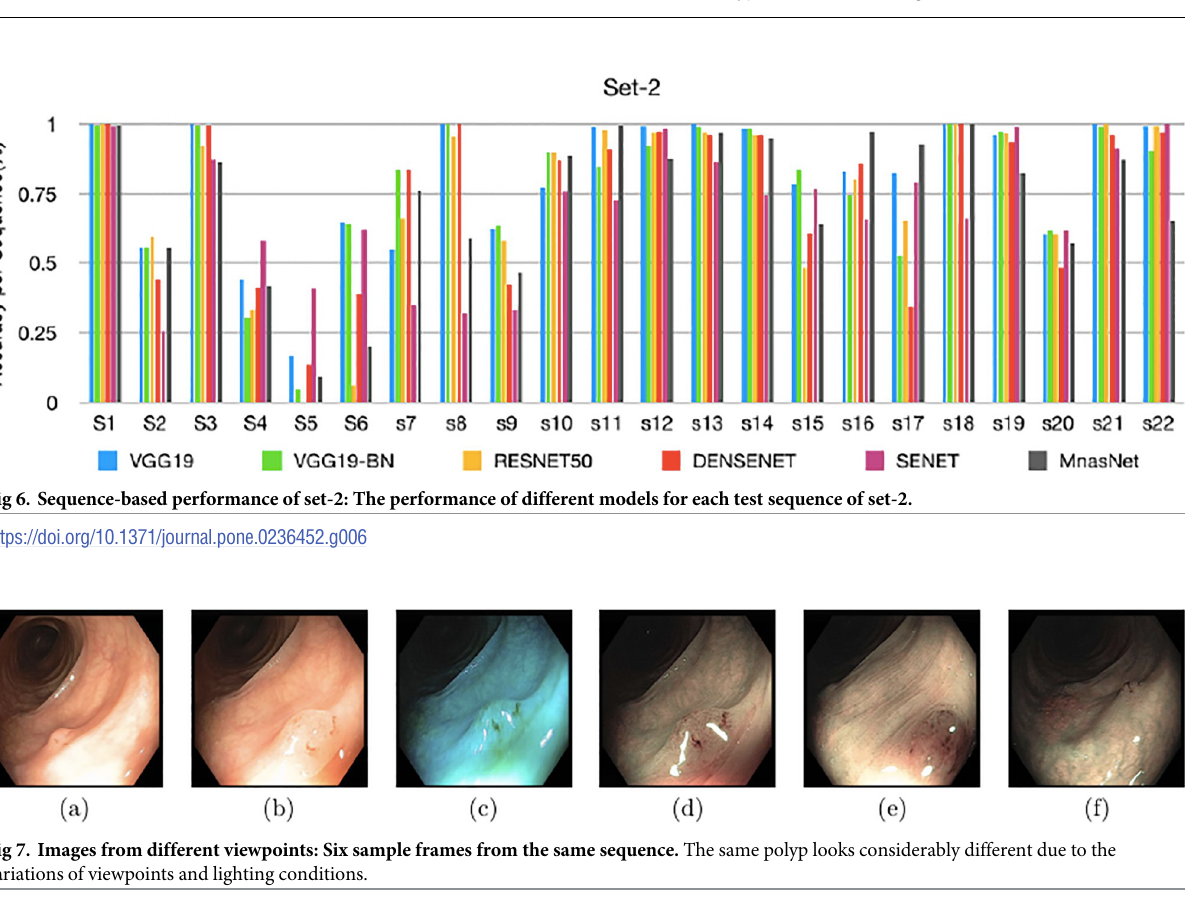
by each of the models. The upper quartile range is dependent on the median value. A high median value decreases the upper half range, which shows the ability of the model to consis- tently correctly classified sequence. On set-1, VGG-19 achieves the highest median value, which indicates that half of the sequences are correctly classified with a very high threshold. On set-2, ResNet-50 yields the most consistent results with the highest median value. We can also see from the results that the upper quartile ranges are smaller than the lower quartile range, which indicates that the spread of accuracy below the median value is very high.